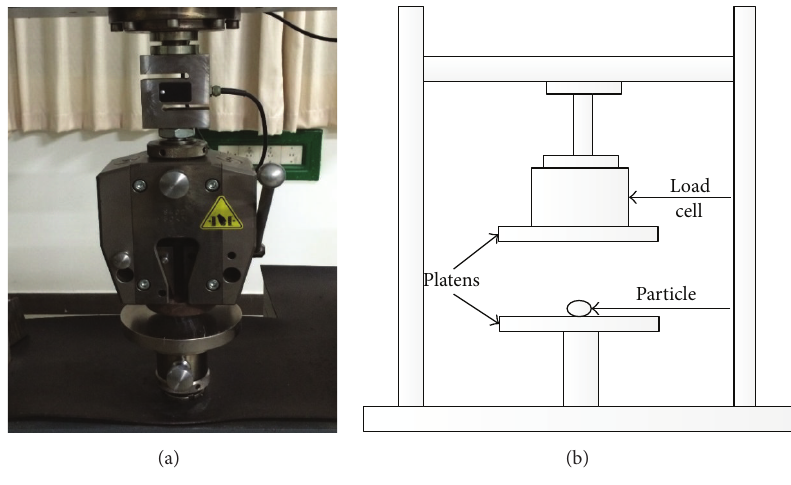
Figure 1: The apparatus of particle crushing test.